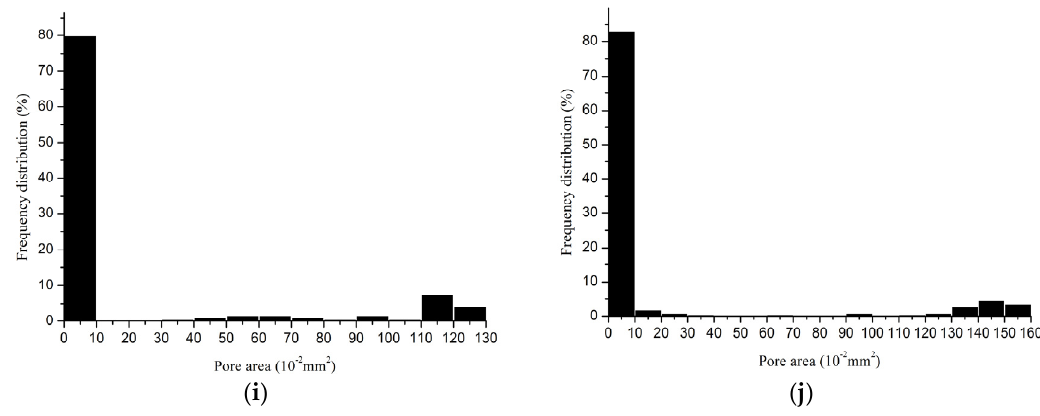
Figure 3. Distribution of pores in all devices. ( a ) Device No. 1; ( b ) Device No. 2; ( c ) Device No. 3; ( d ) Device No. 4; ( e ) Device No. 5; ( f ) Device No. 6 ‐ 1; ( g ) Device No. 6 ‐ 2; ( h ) Device No. 7; ( i ) Device No. 8; ( j ) Device No. 9. Table 3. Pore size and porosity (area method) of single ‐ bar structure devices.